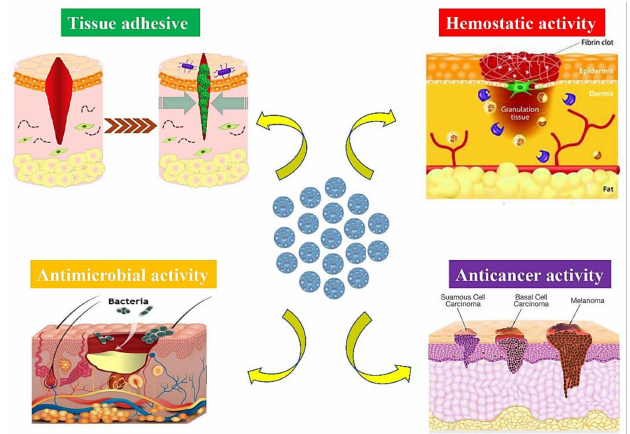
Figure 2. Schematic illustration displaying possible capacity of mesoporous silica nanoparticles (MSNs) (the blue circles in the middle) for managing different skin diseases and